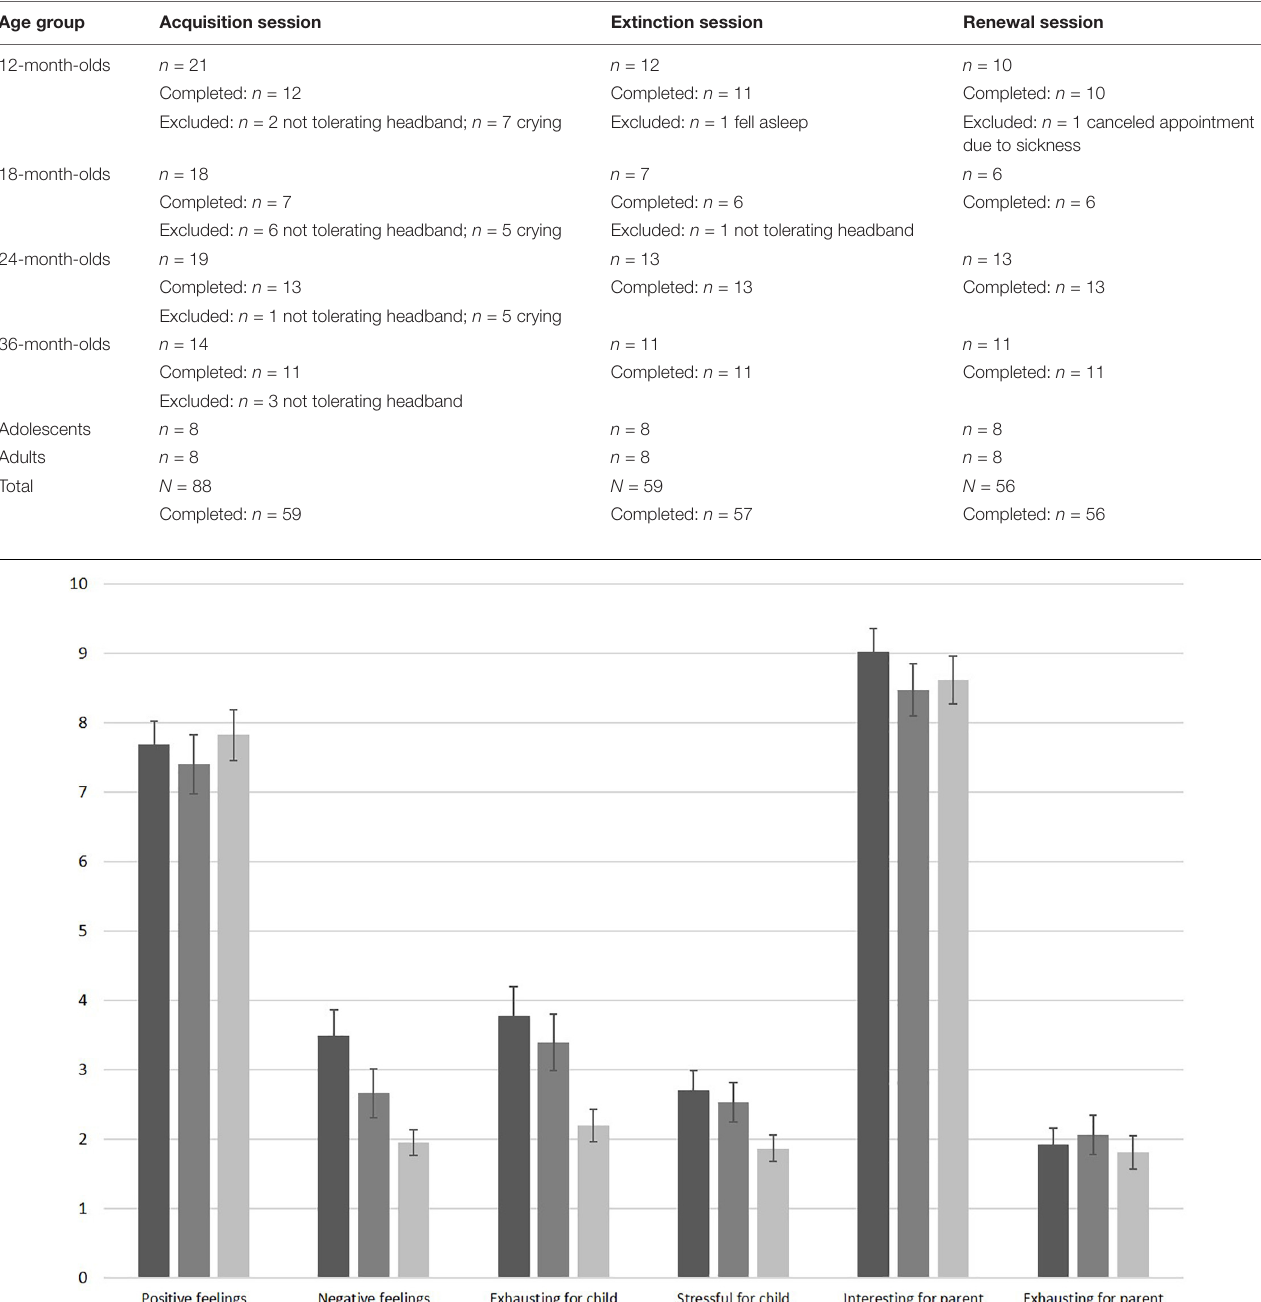
questionnaire. Parents’ ratings on how exhausting the session was for their infant significantly decreased throughout the sessions, F (2, 70) = 7.63, p = 0.001, η p 2 = 0.179. Pairwise comparisons revealed significant differences in infant exhaustion between